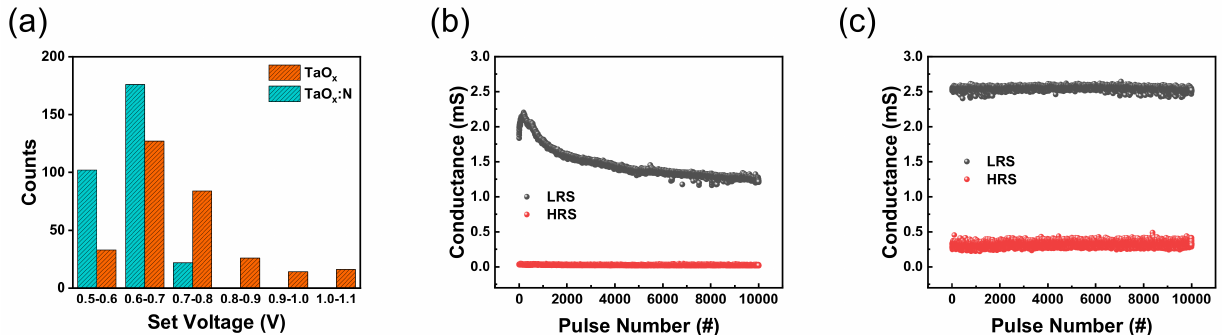
Figure 4. ( a ) Statistical distribution of set voltages for Ta/TaO x /Pt and Ta/TaO x :N/Pt. Pulse endurance characteristics of ( b ) Ta/TaO x /Pt device and ( c ) Ta/TaO x :N/Pt device.